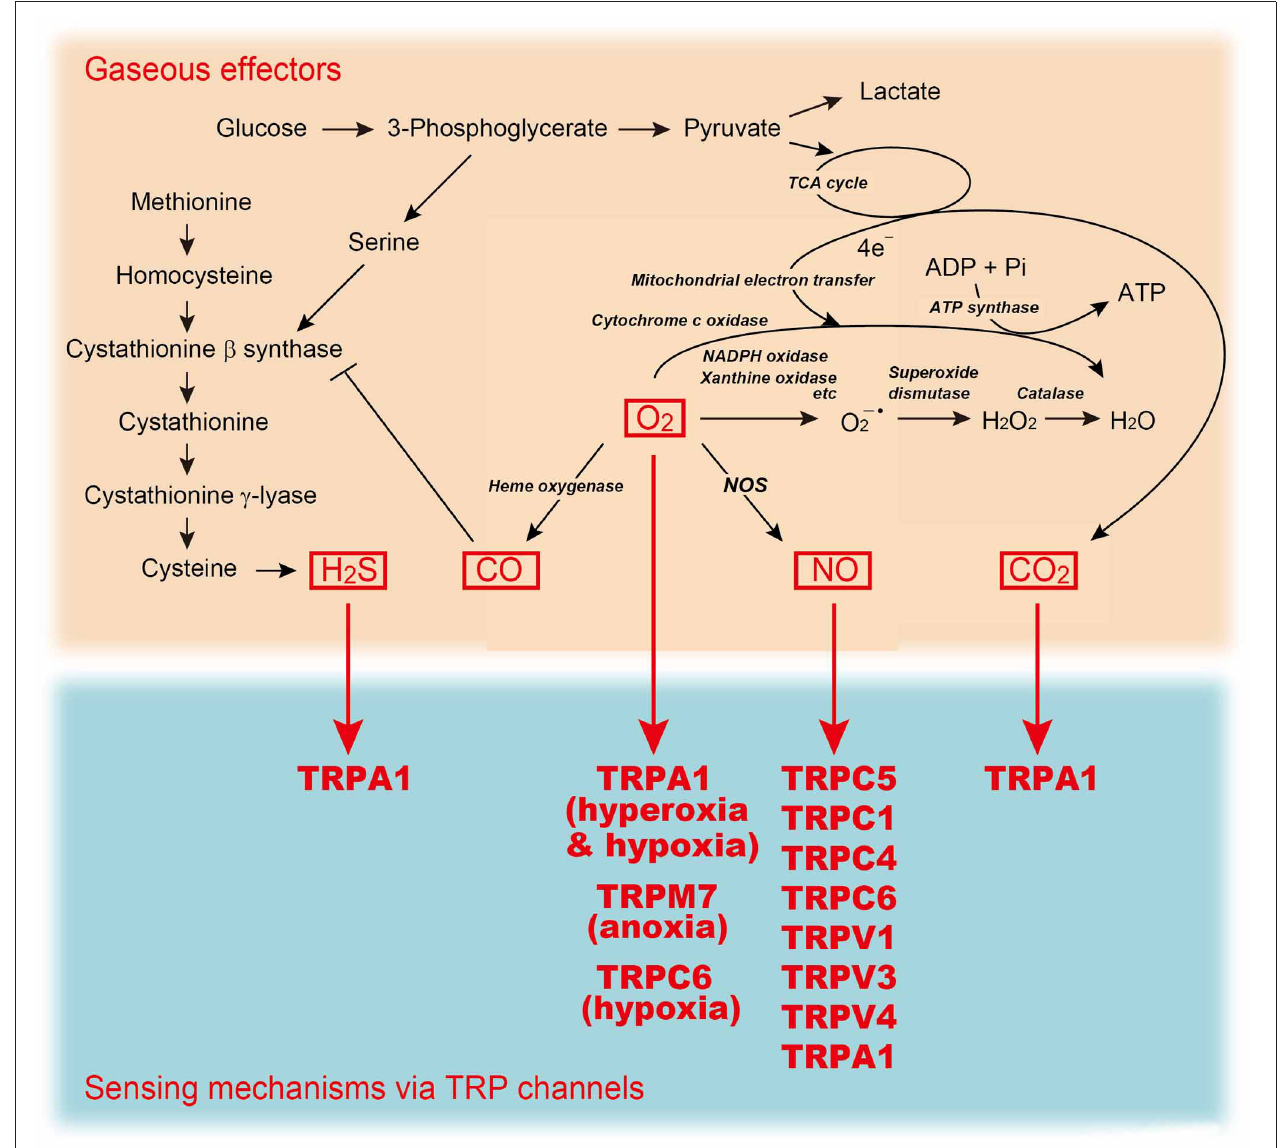
FIGURE 2 | A sensing mechanism for gaseous molecules linked to metabolic pathways. TRP channels mediate sensing mechanism for H 2 S, O 2 (anoxia, hypoxia, or hyperoxia), NO, and CO 2 .